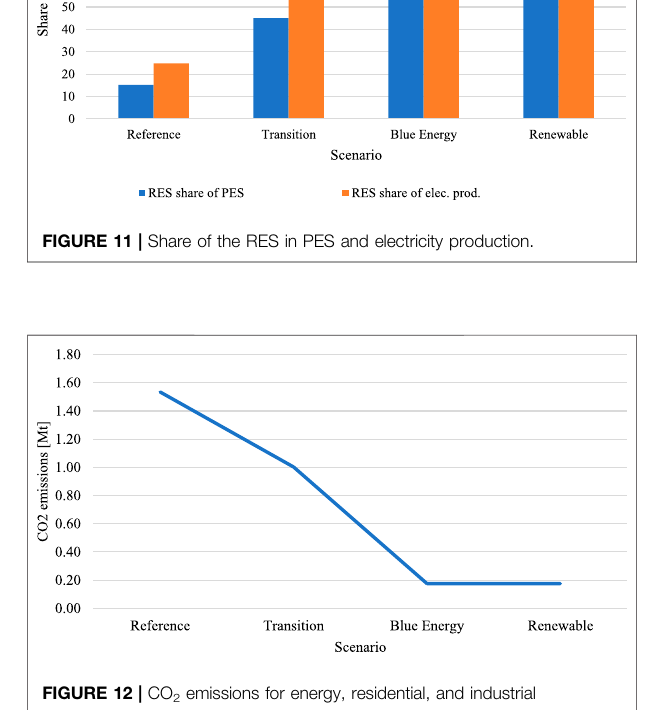
Figure 11 sums up the share of renewable energy sources in electricity production and primary energy supply for assessed sectors. The share of renewables in electricity production increases from 25 to 100% when the offshore wind is deployed in combination with additional PV and onshore wind capacities, and thermal power plants are phased out. Nevertheless, it should be emphasized that a signi fi cant amount of electricity comes from import in this case, for which the production source is not known.